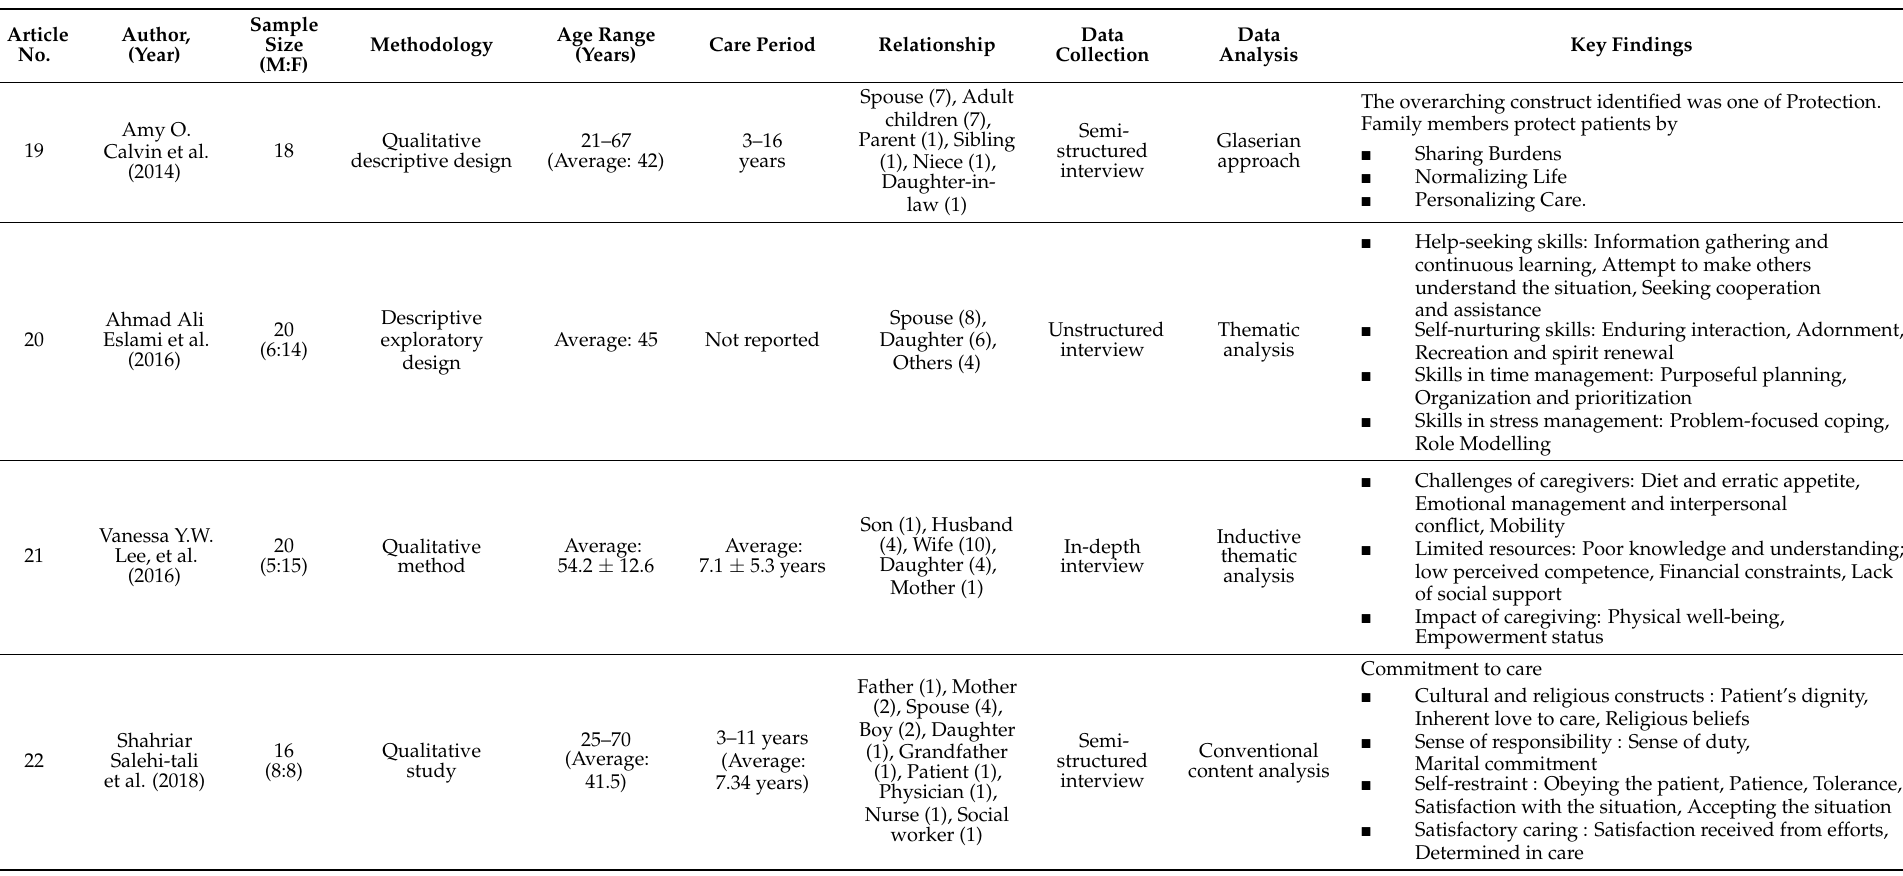
Table 2. Summary of the studies included in the